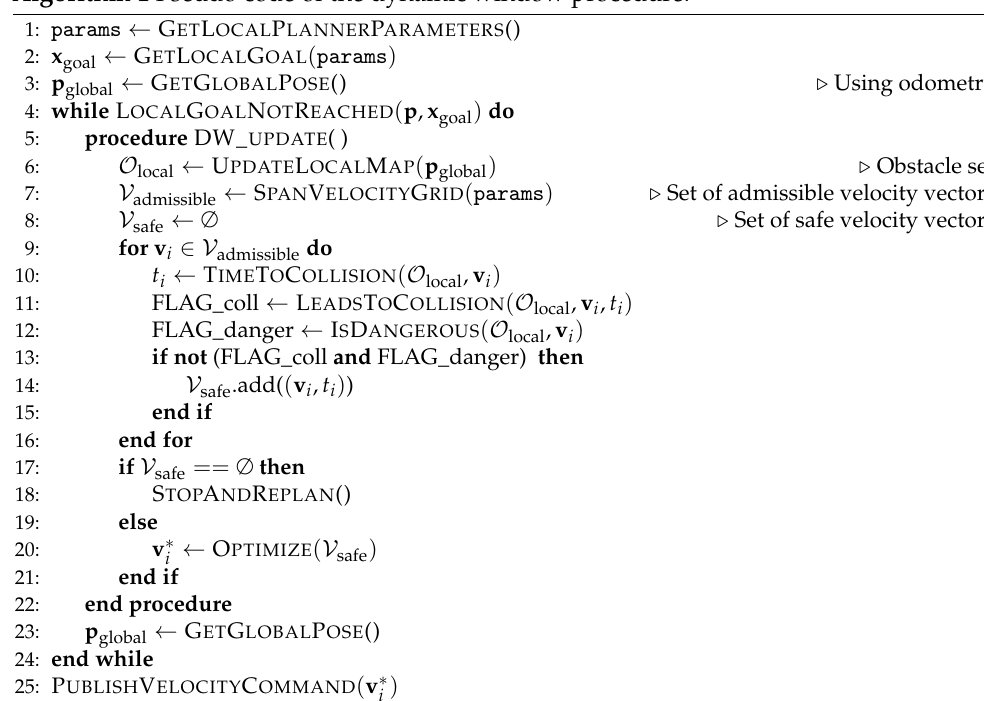
Algorithm 1 Pseudo code of the dynamic window